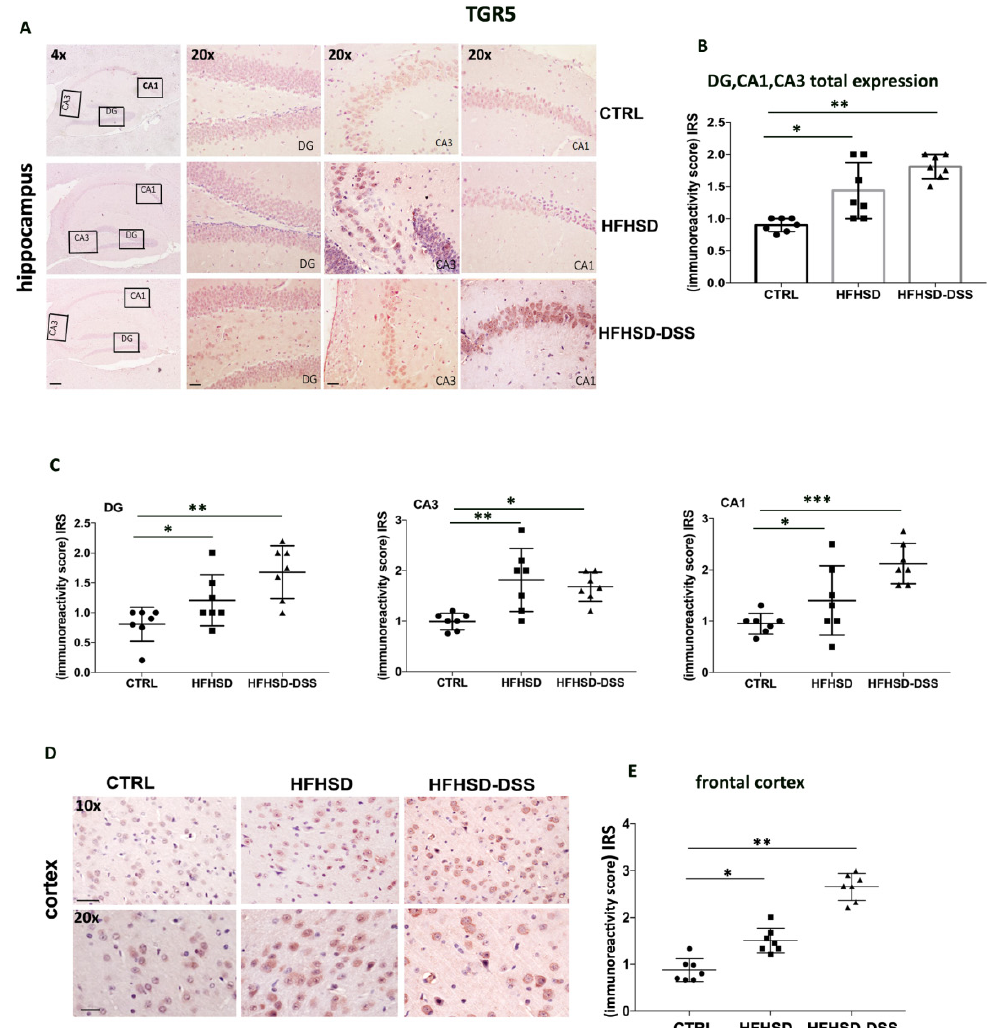
Figure 2. Representative images of immunohistochemistry (IHC) staining of TGR5 in different regions of the hippocampus ( A ) and in the frontal cortex ( D ) displaying the expression and cytoplasmic localization of TGR5. 4 × magnification: Scale bar = 100 µ m. 10 × magnification: scale bar = 50 µ m; 20 × magnification: Scale bar = 25 µ m. Graphic ( B ) reported the average values of immunoreactivity score (IRS) for all analyzed areas. Graphics ( C ) show TGR5 quantification for each district. Graphic ( E ) represent IRS in frontal cortex. Mean ± SD for each group is shown. Statistical significance: * p < 0.05; ** p < 0.01; *** p <0.001.